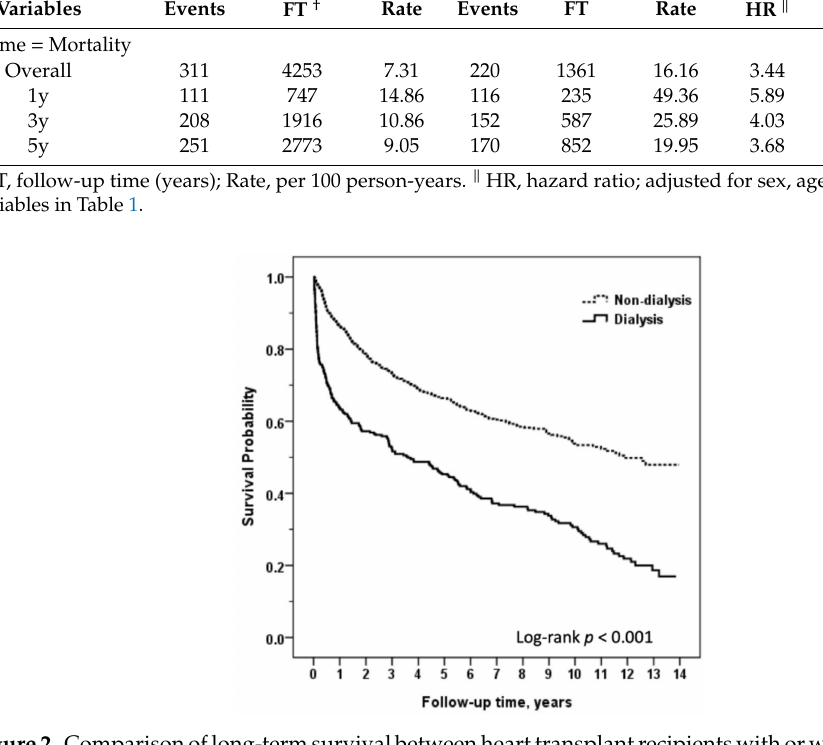
Figure 2. Comparison of long-term survival betweenheart transplant recipients with or without